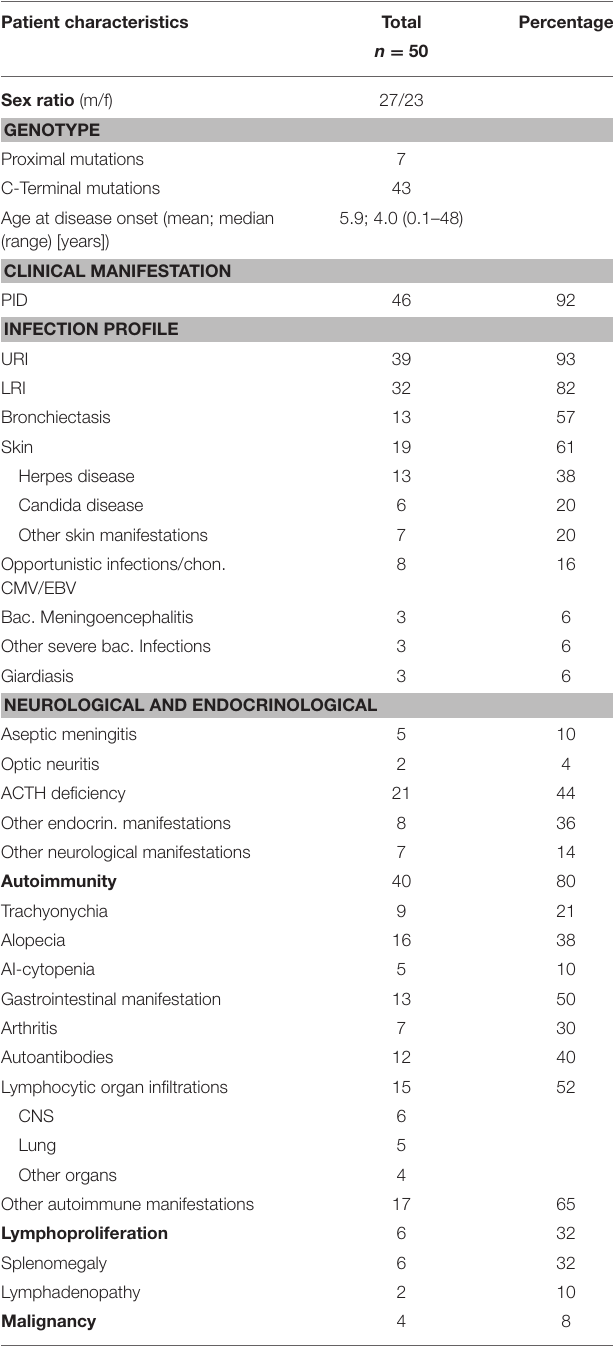
TABLE 4 | Summary of the major clinical manifestations of NF- κ B2 haploinsufficiency. Patient